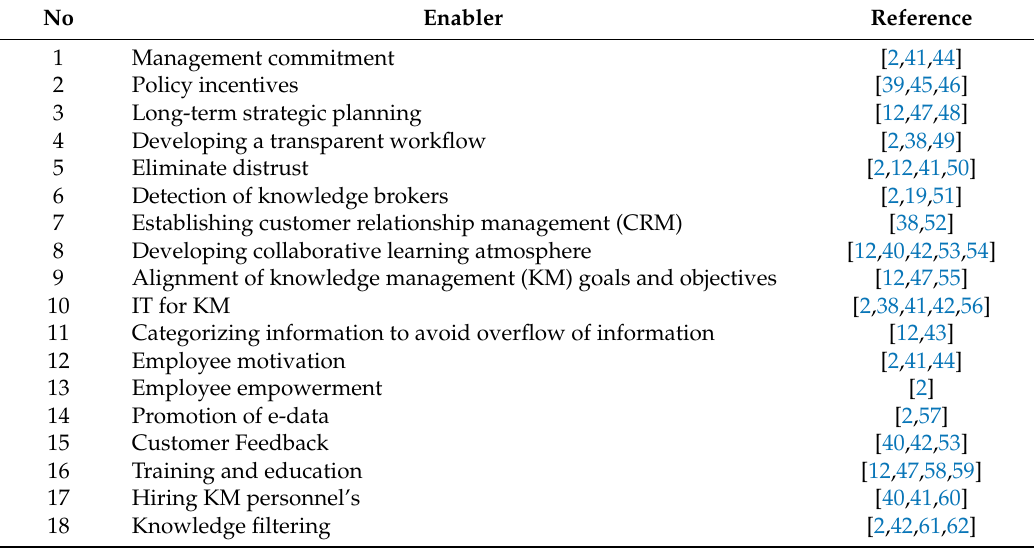
Table 1. Literature review on enablers of knowledge management implementation in the healthcare sector. No Enabler